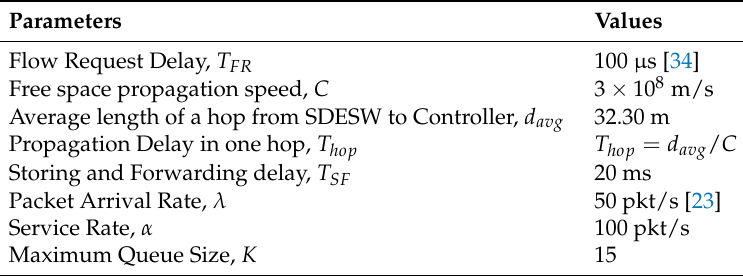
Table 5. List of